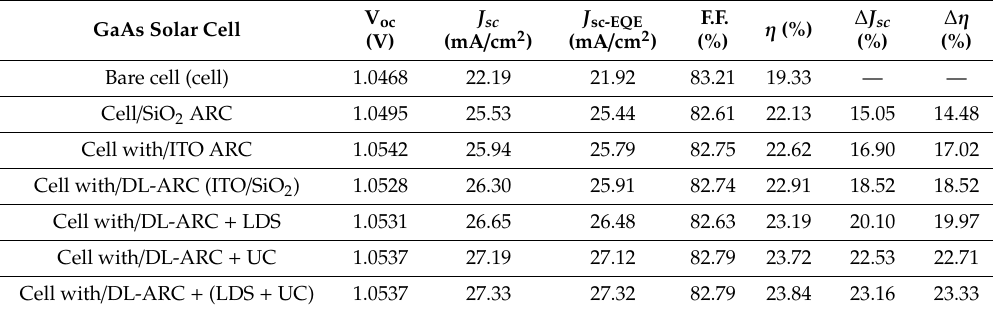
Table 3. Photovoltaic performances of all evaluated cells under AM 1.5 G solar